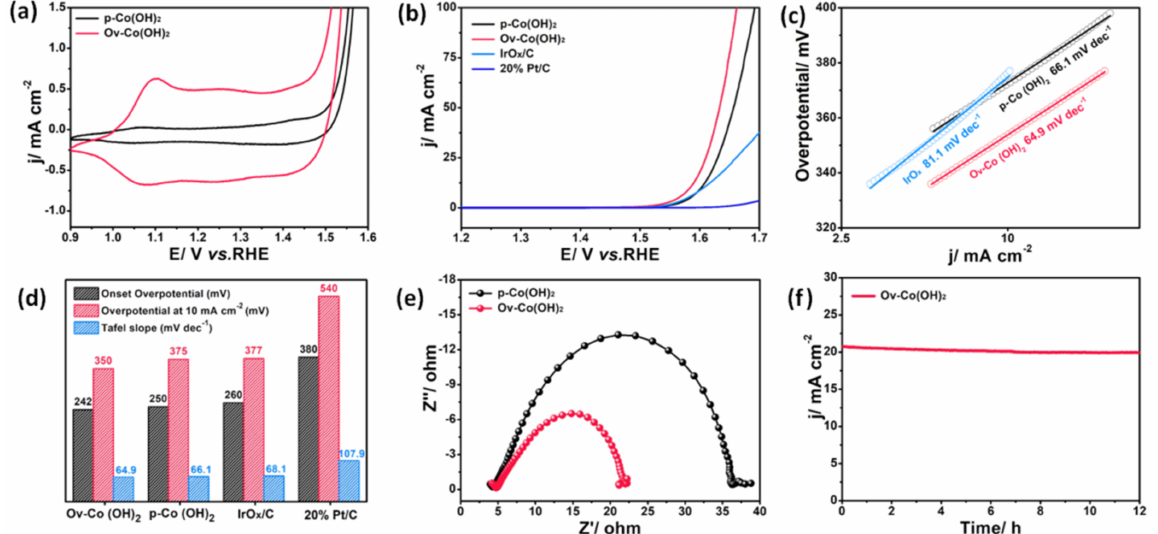
Figure 4. ( a ) Cyclic voltammetry curves of O V − Co(OH) 2 and p –Co(OH) 2 ; ( b ) linear sweep voltam- metry curves of O V − Co(OH) 2 , p –Co(OH) 2 , IrO x and Pt/C; ( c ) corresponding Tafel slopes of O V − Co(OH) 2 , p –Co(OH) 2 and IrO x ; ( d ) comparison of oxygen evolution reaction catalytic parame- ters O V − Co(OH) 2 , p –Co(OH) 2 , IrO x and Pt/C; ( e ) Nyquist plots of O V − Co(OH) 2 and p –Co(OH) 2 ; ( f ) chronopotentiometric curve at the overpotential of 350 mV for O V − Co(OH) 2